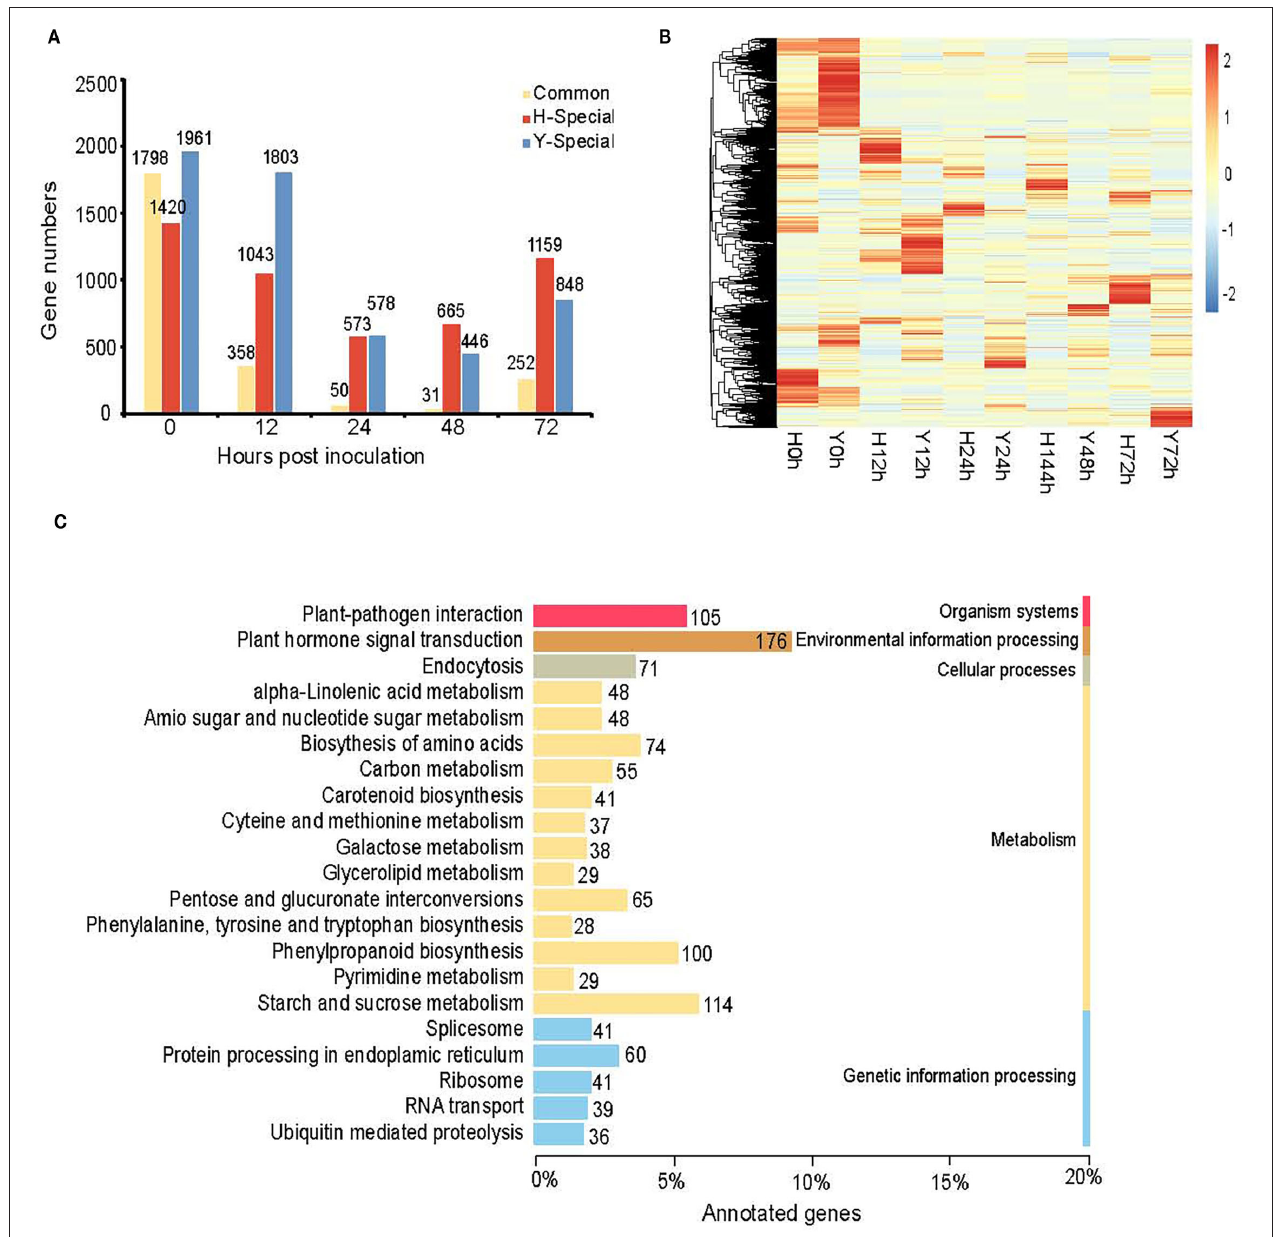
FIGURE 4 | Specially expressed genes at 0, 12, 24, 48, and 72 hpi for Y and H. (A) Bar graph showing the number of specifically expressed genes specifically and commonly in Y and H at each time point. (B) Heatmap showing the expression profile of specifically expressed genes at different time points in both cultivars. The color scale represents Z -score. (C) The top 21 enriched KEGG pathways of specifically expressed genes for five time points in Y and